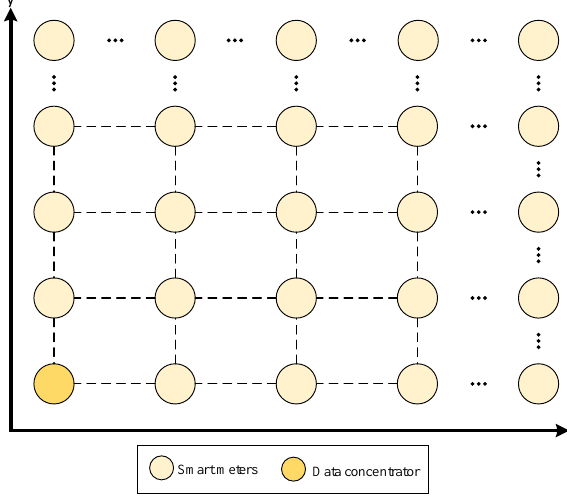
Figure 6. Scenario under